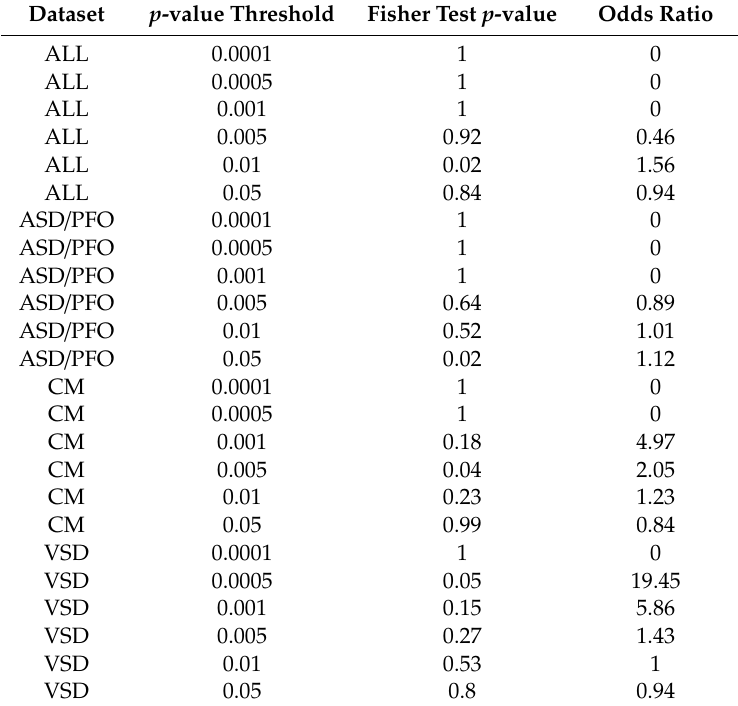
Table 2. Evaluation of the extent of shared genetic e ff ects between neuroblastoma (NB) and congenital heart disease